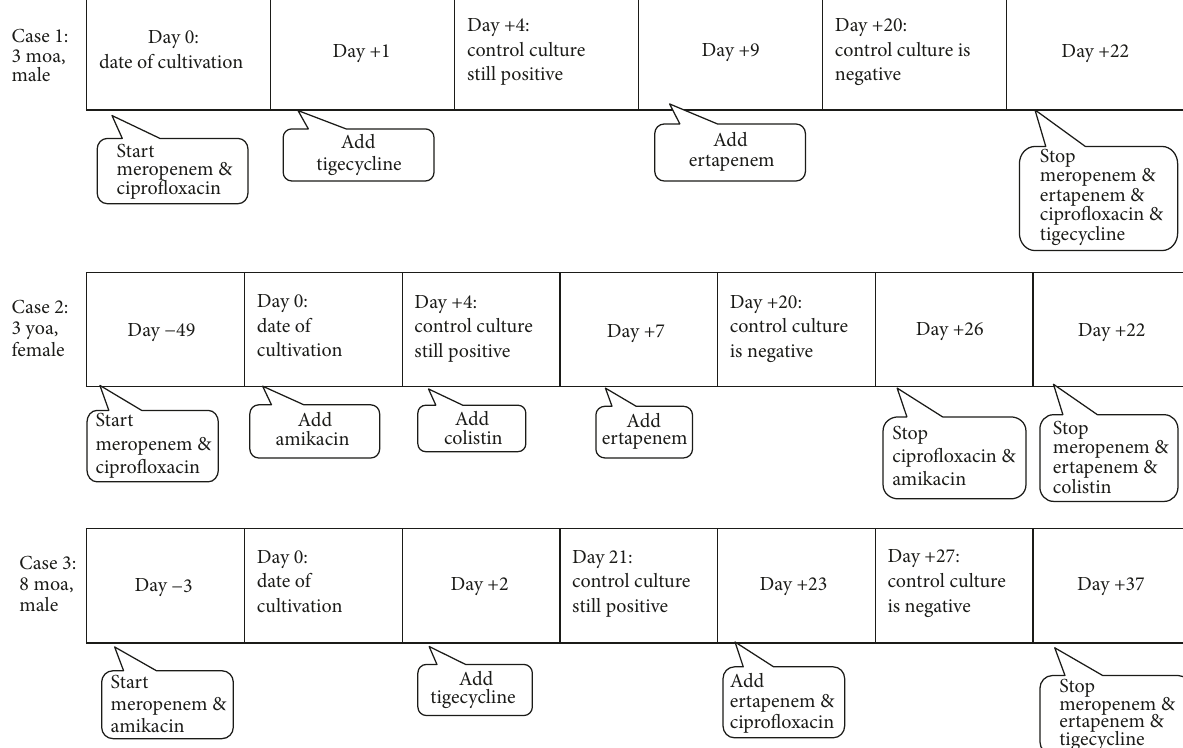
Figure 1: Timeline of treatment for Gram-negative bacteria and follow-up. Dosages of Drugs. Meropenem: 20–40 mg/kg every 8 hours; ciprofloxacin: 6–8mg/kg every 8 hours; tigecycline: 1–1.5 mg/kg every 12 hours; ertapenem: 15mg/kg every 12 hours; amikacin: 15 mg/kg every 24 hours; colistin: 2.5–5mg/kg/day in 3 divided